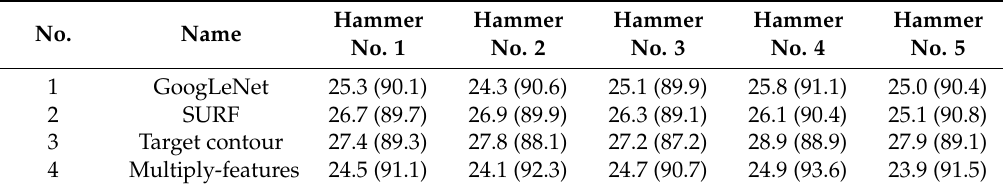
Table 4. Mean error of the center points (pixel) and the success rate (%).